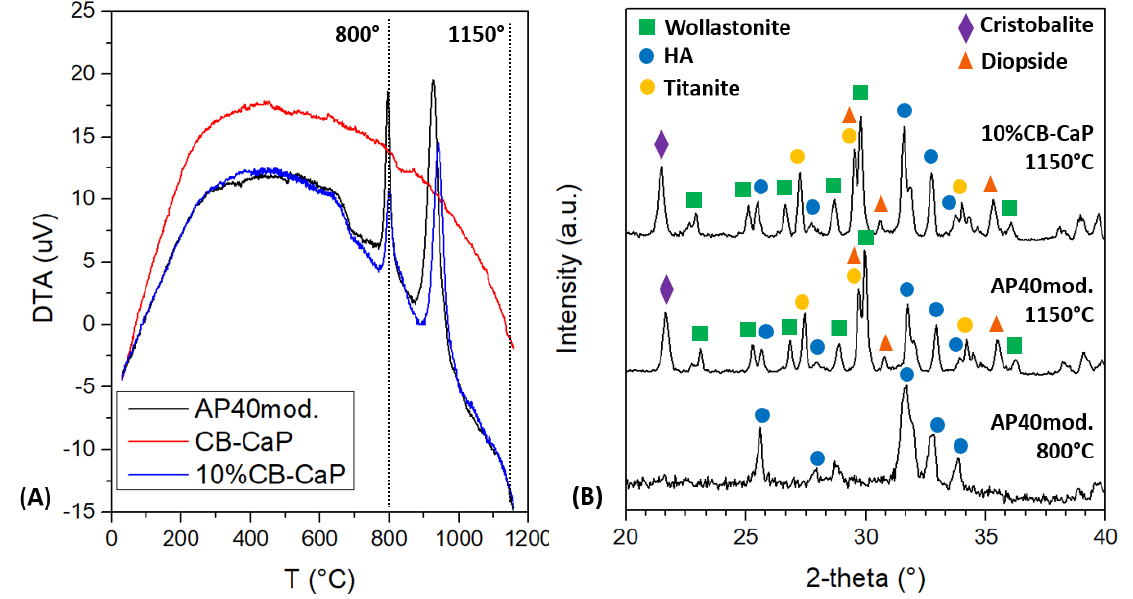
Figure 4. DTA analysis of the powders ( A ) and XRD spectra of the samples sintered at 1150 °C and of AP40mod treated at 800 °C ( B ).